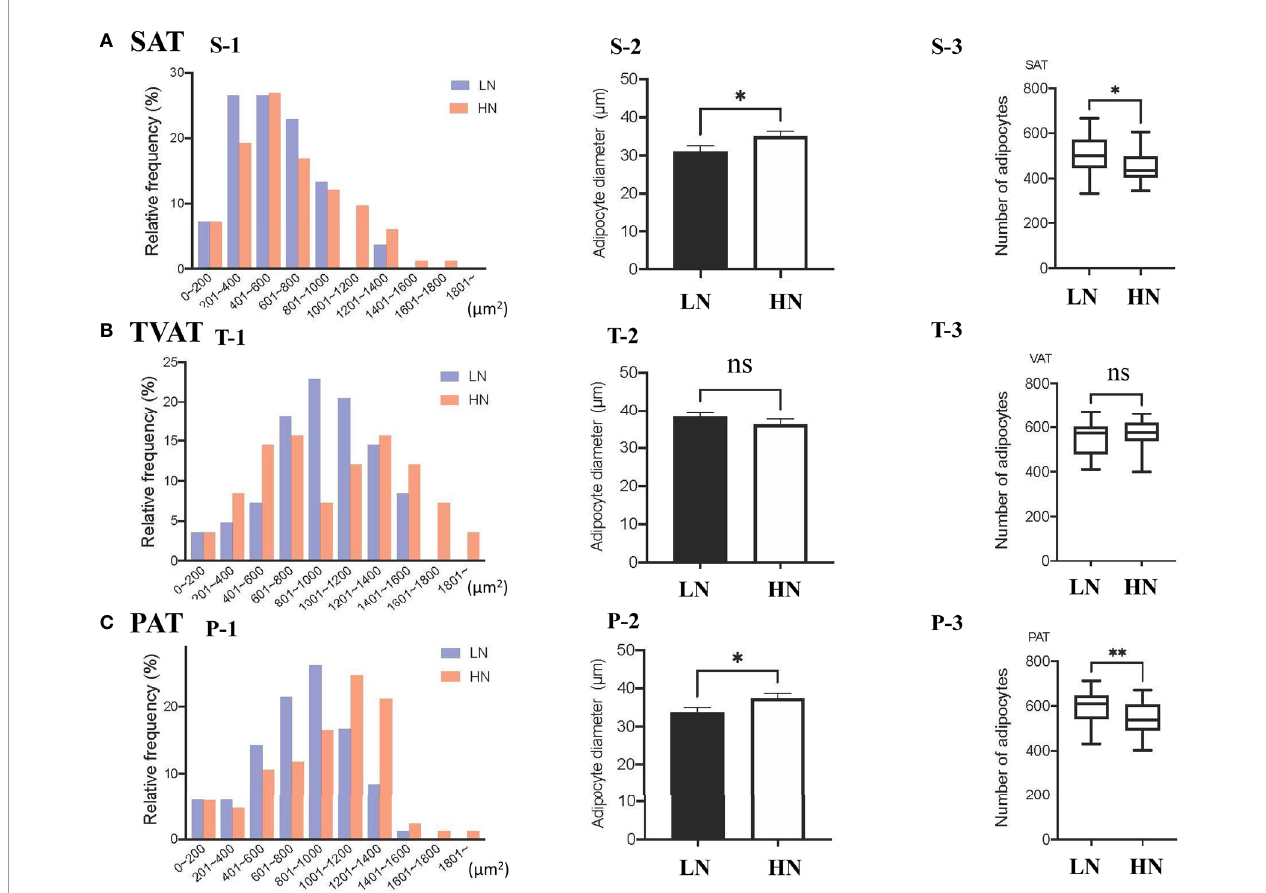
FIGURE 1 | (A) Relative frequency distribution of SAT CSA (S-1), diameter (S-2), and number of adipocytes within the same area (S-3) in subcutaneous adipose tissue (SAT) between LOW and HIGH fetuses. (B) Relative frequency distribution of TVAT CSA (T-1), diameter (T-2), and number of adipocytes in the same area (T-3) in thoracic cavity visceral adipose tissue (TVAT) between LOW and HIGH fetuses. (C) Relative frequency distribution of PAT CSA (P-1), diameter (P-2), and number of adipocytes within the same area (P-3) in perirenal adipose tissue (PAT) between LOW and HIGH fetuses. Fetuses: 260 ± 8.3 days of fetal age. LOW: n=6. HIGH: n=6. Values are means with standard errors. Signi fi cant differences between fetal groups are denoted by * p < 0.05 and ** p <